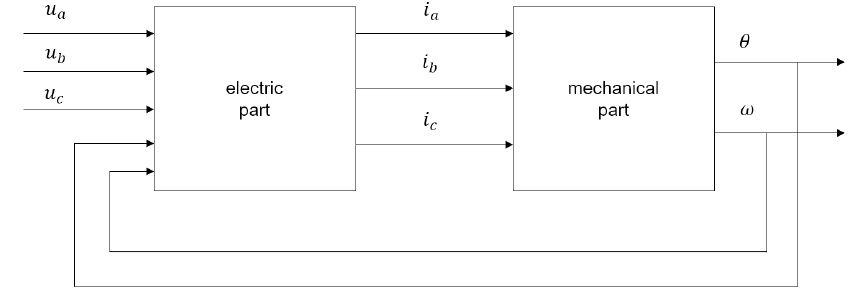
Figure 5. Block Diagram Model of the Motor.